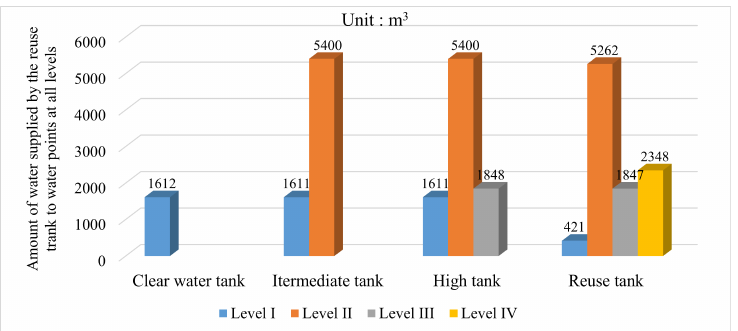
Figure 13. Statistical chart of mine water reuse scheduling in heating season.